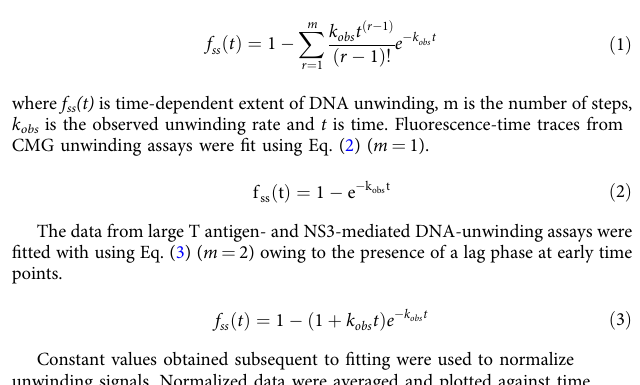
to prevent reannealing of the Cy5-labeled strand to the quencher-modi fi ed strand. Comp LagTail used for the fork substrate containing 28-bp duplex region (Figs. 3e and 6a) was Oligo-12. Comp LagParent and Comp LeadParent used in Fig. 6b and Supplementary Fig. 6 for the 60-bp fork DNA were Oligo-20 and Oligo